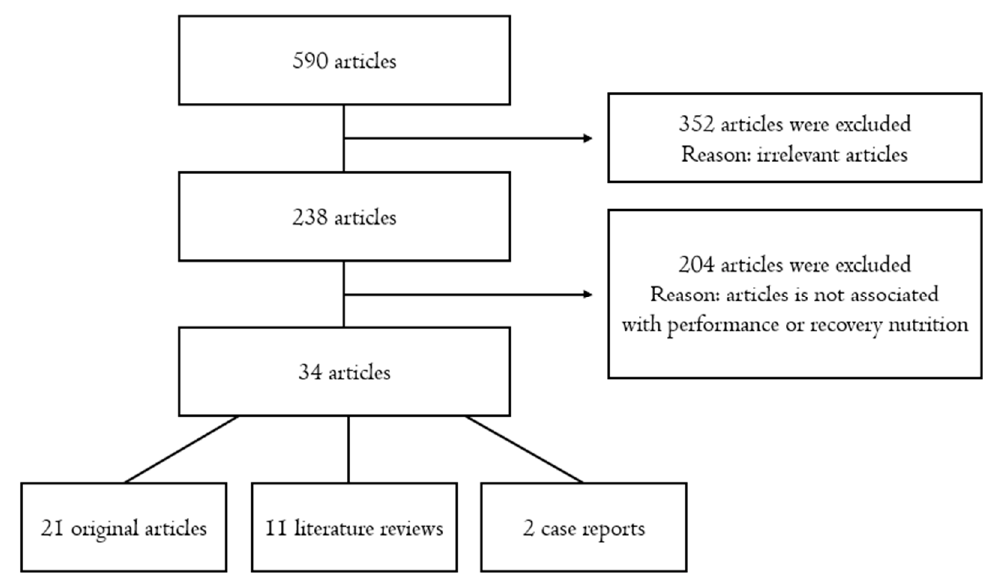
Figure 1. Flowchart of the literature search process.